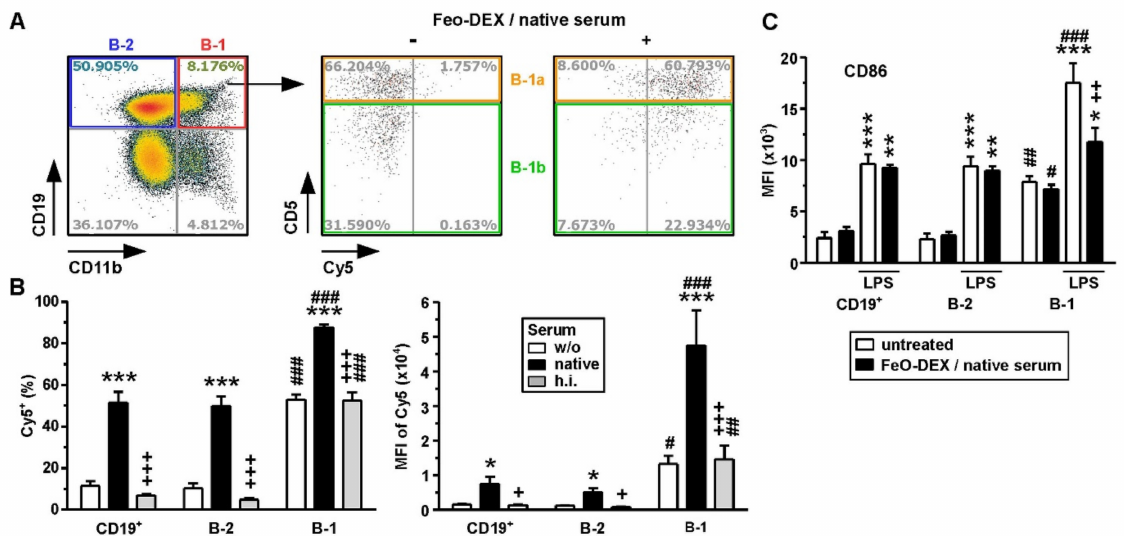
Figure 6. B-1 cells engage FeO-DEX to a higher extent than B-2 cells but are affected in their activation state. Spleen cells were incubated over-night with differentially pretreated (left untreated (w/o), pretreated with native or heat-inactivated (h.i.) serum) FeO-DEX. ( A ) FACS plot identifying splenic B-1 cells that co-express CD19 and CD11b (left panel) and delineating CD5 + B-1-a and CD5- B-1b cells, which engage native serum-pre-incubated FeO-DEX (right panel). Plots are representative of 4 experiments. ( B ) Frequencies of Cy5 + (left panel) and MFI of Cy5 (right panel) of B cell populations (total B cells (CD19 + ), B-2 cells (CD11b-CD19 + ) and B-1 cells (CD11b + CD19 + )). Data denote the mean ± SEM of 3 experiments. Statistical differences versus *w/o, +native serum, #B-1 versus B-2 (corresponding group) are indicated (one-way ANOVA, Tukey’s test). ( C ) Quantification of CD86 activation marker expression (MFI) of B cell populations (see above) after over-night incubation with native serum-pretreated FeO-DEX (mean ± SEM of 3 experiments). Statistical differences versus *according to the group at unstimulated state, # B-1 versus B-2 (corresponding group) and + LPS-stimulated are indicated (one-way ANOVA, Tukey’s test). ( B , C ) * ,+,# p < 0.05, ** ,++,## p < 0.01, *** ,+++,### p <